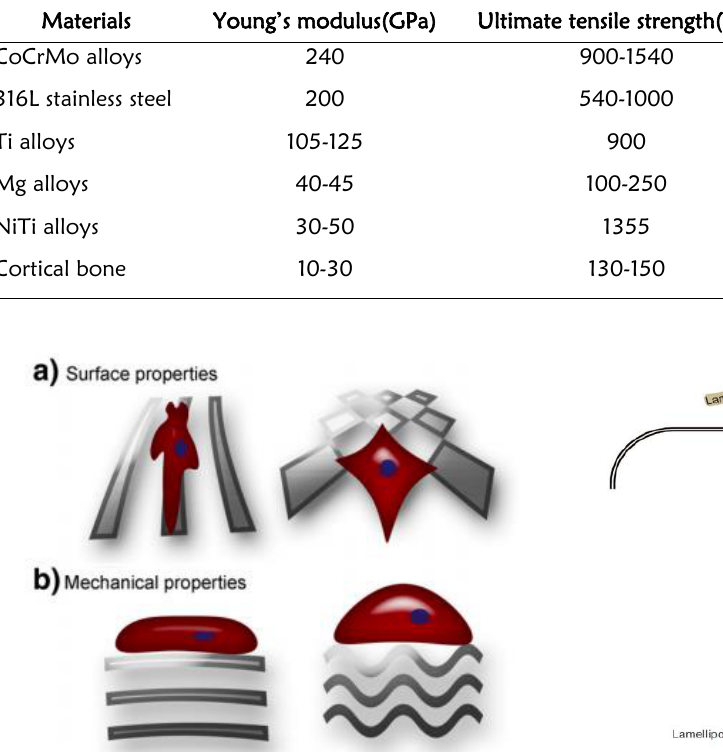
Figure 2: The signalling pathway in the adhesion of stem cells to bone biomaterials